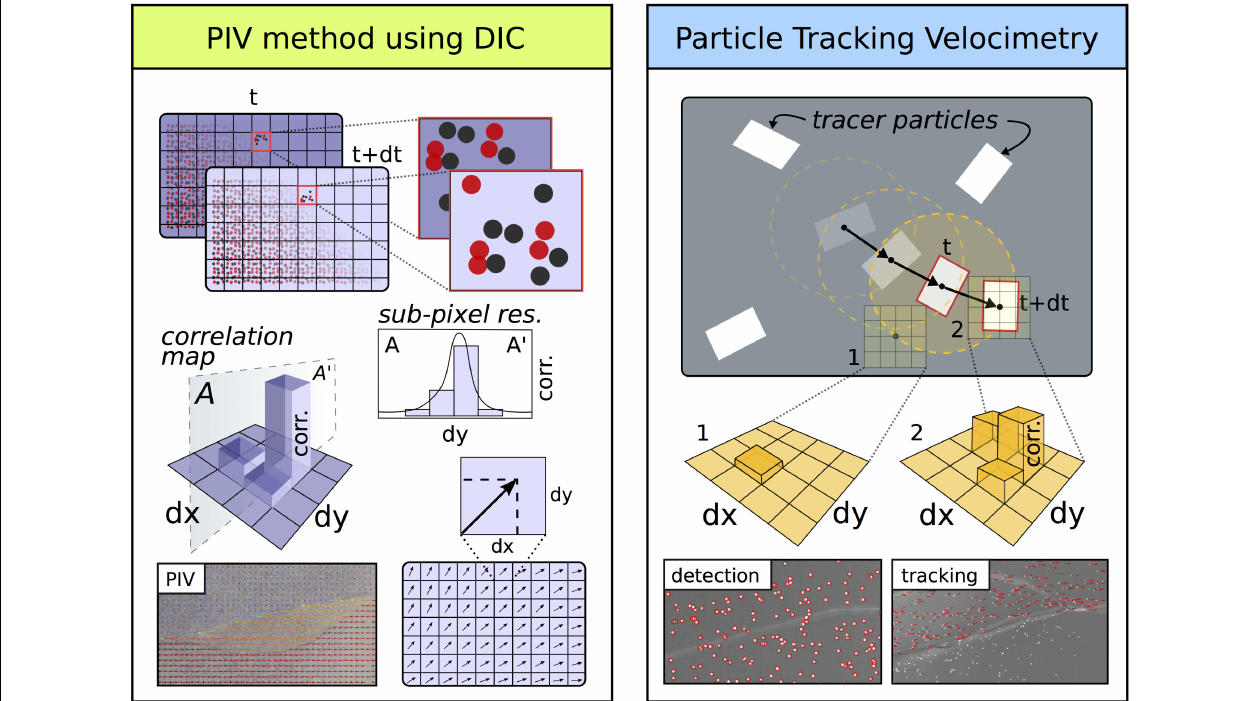
FIGURE 4 | Particle image velocimetry (PIV) method employs digital image correlation (DIC) to measure the change in displacement within each gridded cell for a sequence of images (left panel). The grid remains fixed within a Eularian reference frame with cell size predetermined based on the expected displacement increment and desired spatial resolution. Within each gridded cell, small high-contrast surface markers form a unique pattern that is used to identify each cell’s vector of displacement between two sequential frames. A correlation map identifies the grid-locations ( dx , dy ) with the strongest match from the previous frame. Fitting the correlation map with a Gaussian curve allows for sub-pixel spatial resolution. PTV, however, employs a non-fixed Lagrangian reference frame to track the displacement and velocity of individual particles. The tracer particles are detected based on size and color contrast with the background image and then given unique identifiers (bottom right). Between frames, the area around each particle is searched using a grid to identify the location with the strongest matching pattern (top right). The radius of the grid search is likewise dependent on the displacement increment and the desired spatial